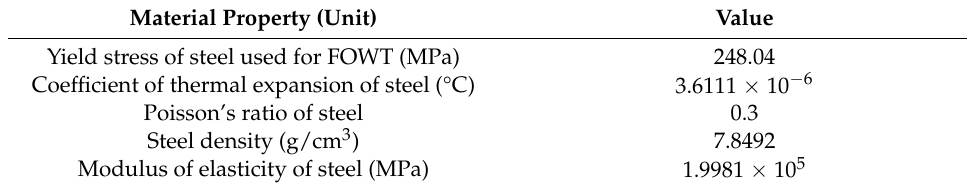
Table 3. Material properties of FOWT with inclined tension legs.